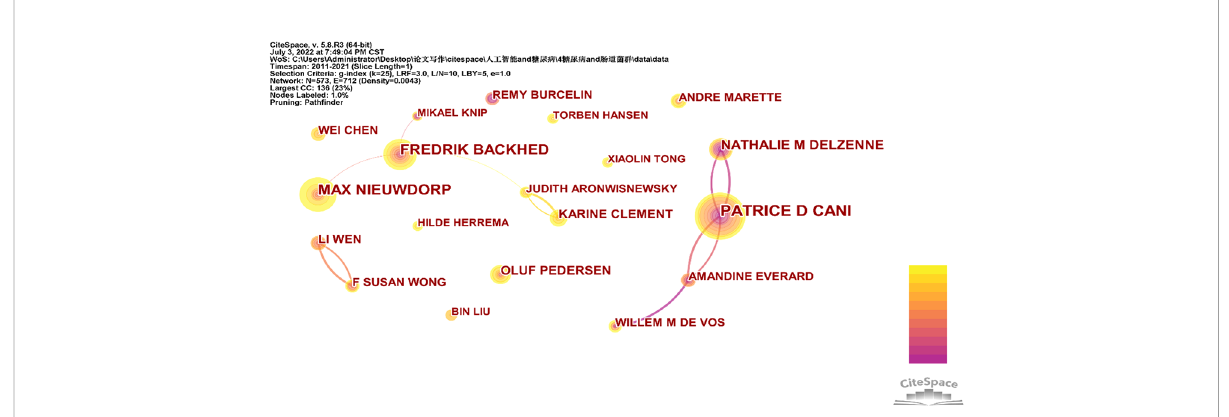
FIGURE 4 Collaboration between eminent article writers.